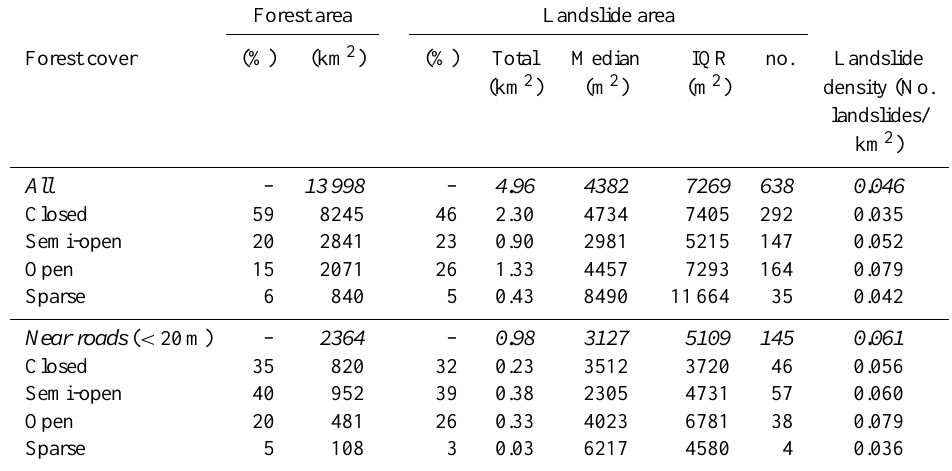
Table 5. Characteristics of landslide initiation sites with respect to forest cover and forest service